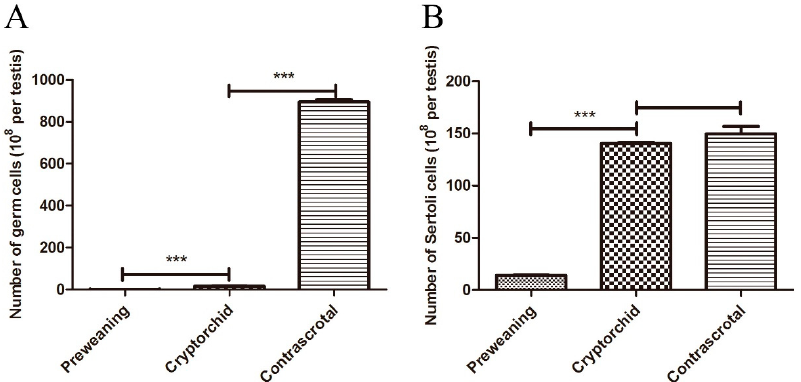
Figure 2. The number of germ and Sertoli cells in seminiferous tubules of boar testes. The number of germ and Sertoli cells ( A ) and ( B ) in preweaning, cryptorchid, and contrascrotal testes. *** p < 0.001.